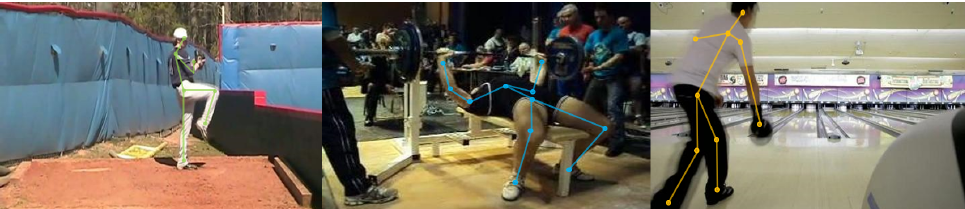
Figure 6. Result of pose estimation. Figure shows the skeletons for pitching, bench press, and bowling poses,